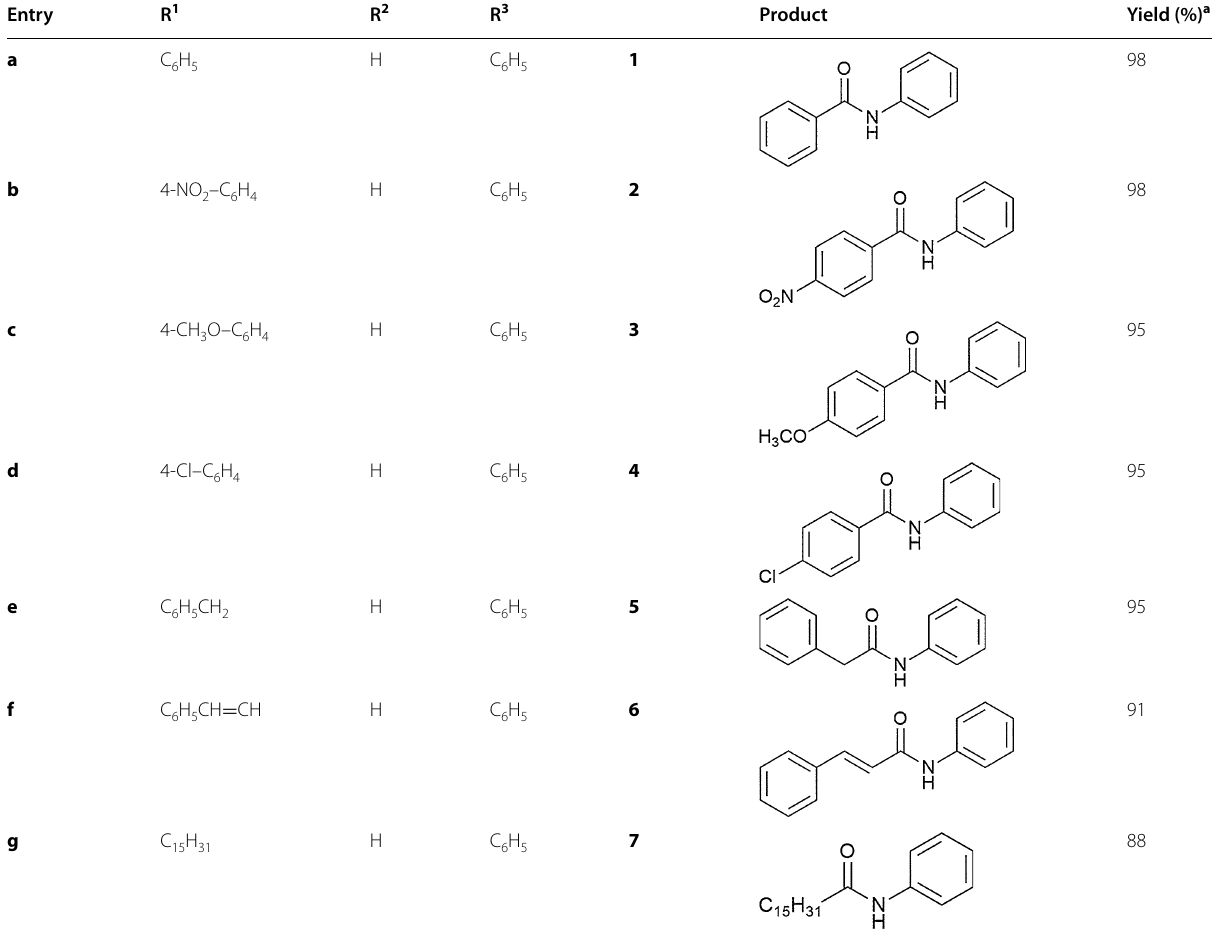
Table 1 Synthesis of N -phenylamides 1